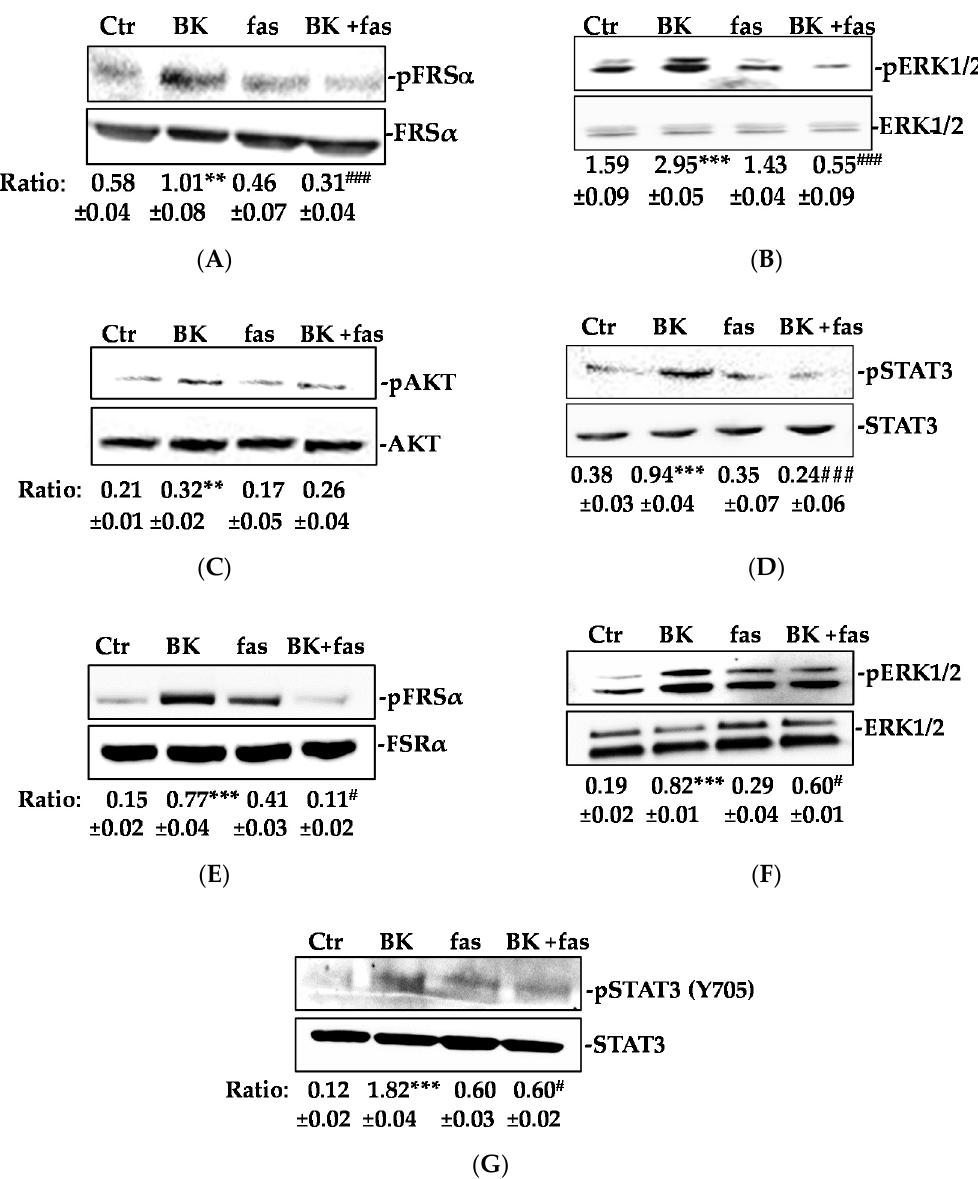
Figure 2. BK/B2R activates FGFR-1 signaling. ( A ) FRS α , ( B ) ERK1/2, ( C ) AKT, and ( D ) STAT3 phosphorylation were evaluated using western blot analysis in HUVEC treated with fasitibant (fas, 1 µM, 30 min), then stimulated with BK (1 µM) for 15 min. ( E ) FRS α , ( F ) ERK1/2, and ( G ) STAT3 phosphorylation were evaluated using western blot analysis in HREC treated with fasitibant (fas, 1 µM, 30 min), then stimulated with BK (1 µM) for 15 min. Results were normalized to FRS α , ERK1/2, AKT, and STAT3, respectively. The results presented are representative of three independent experiments ( n = 3) with similar results. Quantification was expressed as an arbitrary density unit (ADU). ** p < 0.01; *** p < 0.001 vs. Ctr; # p < 0.05; ### p < 0.001 vs. BK treated cells. BK/B2R signaling is reported to directly promote ERK1/2 and STAT3 activation